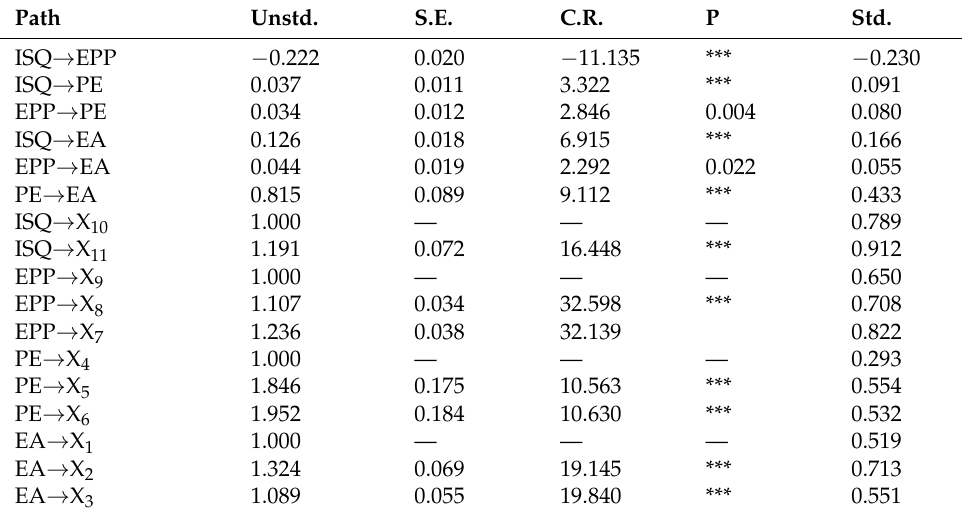
Table 4. Regression results between SEM